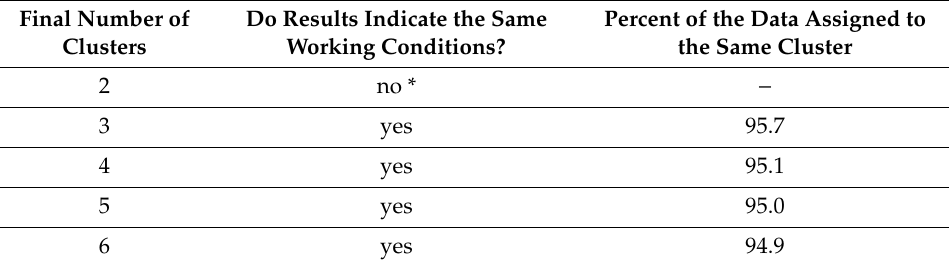
Table 3. Comparison of clustering results for the completed database to the reduced one. Final Number of Do Results Indicate the Same Percent of the Data Assigned to Clusters Working Conditions? the Same Cluster 2 no * − 3 yes 95.7 4 yes 95.1 5 yes 95.0 6 yes